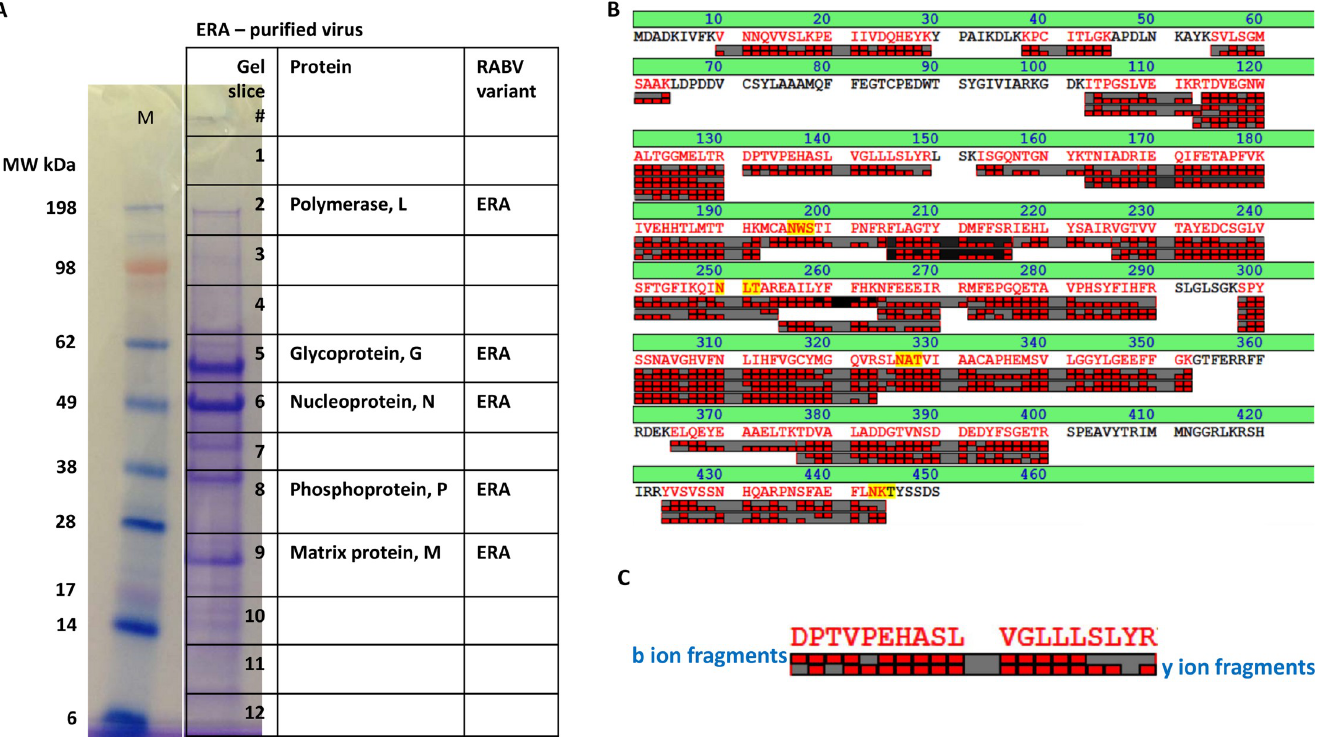
Fig 1. MS analysis of purified RABV ERA virus. (A) RABV ERA virus variant purified from culture supernatants by sucrose density gradient centrifugation was denatured by 1X LDS sample buffer, separated on 4%– 12% Bis-Tris NuPAGE gels and twelve 1-mm slices were analyzed by MS. Molecular weight of protein standards in kilodalton (kDa) is indicated. M–molecular weight marker. The gel slices in which RABV proteins detected are indicated. (B) The peptides identified by MS/MS fragmentation is highlighted in red. The predicted glycosylation sites are highlighted in yellow. (C) One of the MS/MS peptide fragments derived from N protein provided in (B) is enlarged and